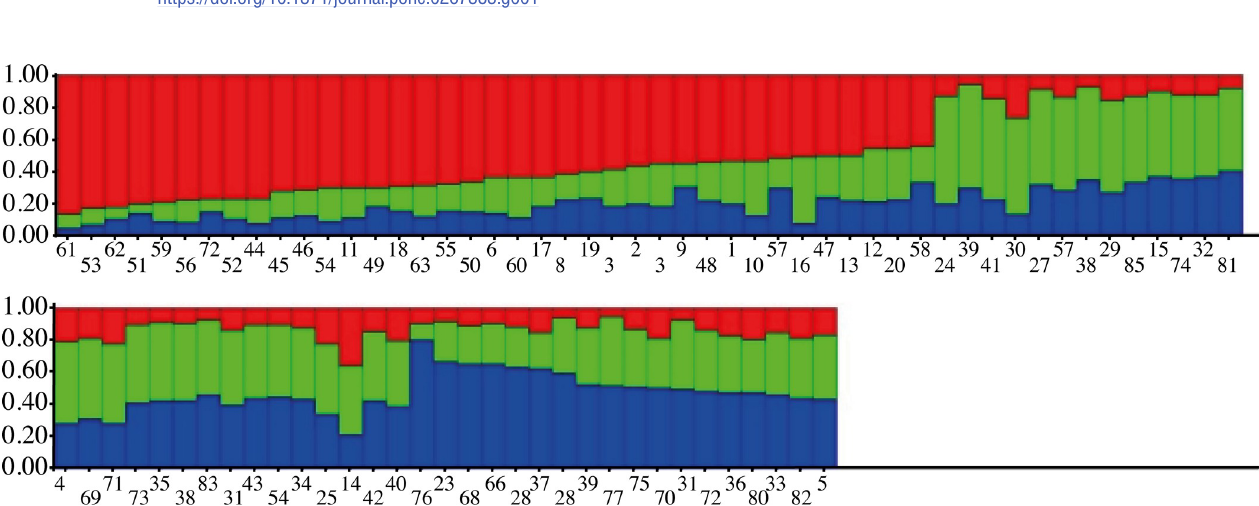
Fig 2. Genetic relatedness of individuals from 83 sunflower populations using Structure software. Numbers on y-axis show the membership coefficient to sub-populations and numbers on x-axis show the individual code belongs to sunflower populations.